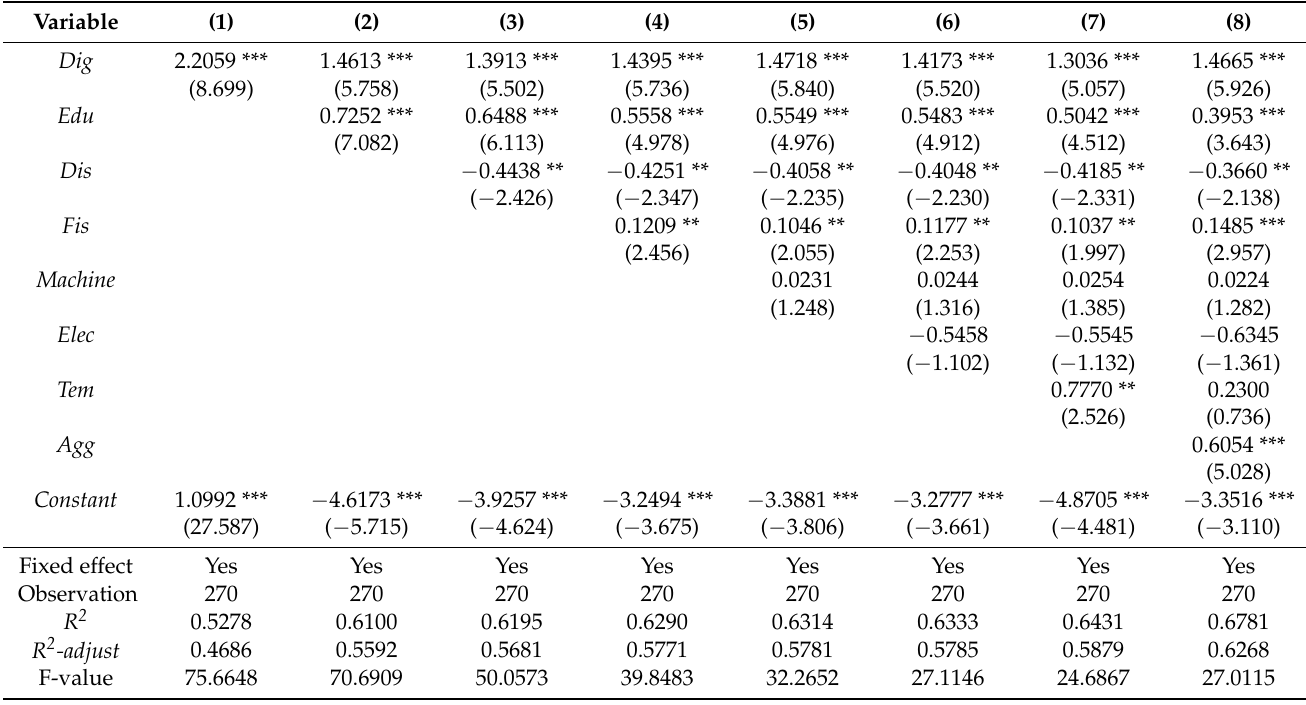
Table 5. Benchmark regression